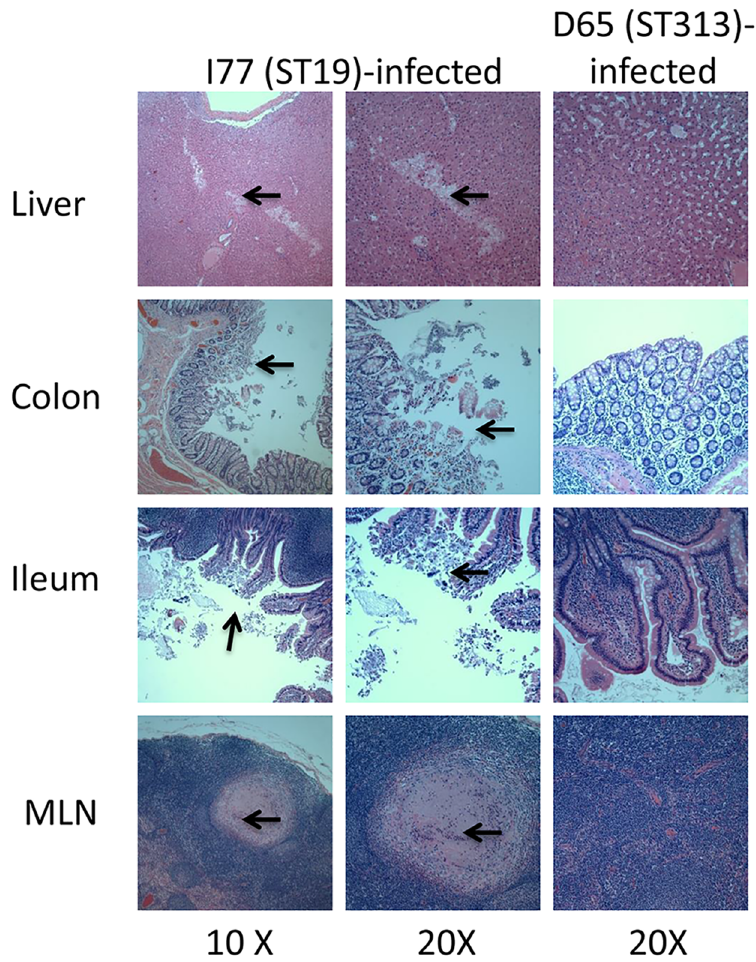
Fig 4. Histopathology of tissues infected with Salmonella Typhimurium. Hematoxylin and eosin-stained sectionsof liver, colon, ileum and mesenteric lymph node (MLN) from rhesus macaques.The images in the left (10X magnification) and middle(20X magnification) columns are from animalsinfected with Salmonella Typhimurium I77 (ST19). Images on the right (20X magnification) are from animalsinfected with Salmonella Typhimurium D65 (ST313). Areas of necrosis and lymphocytic infiltrationof the liver section from a ST19-infected animal are indicatedby arrows. Tissue sections from a ST19-infected animal show areas of erosion of mucosal epitheliumof the colon and ileum combinedwith areas of infiltrationof lymphocytes and plasma cells. These areas are indicatedby arrows. Granulomatous areas consistingof multinucleated giant cells in the mesenteric lymph node of the animal infected with ST19 are indicatedby arrows. All sections from D65-infected